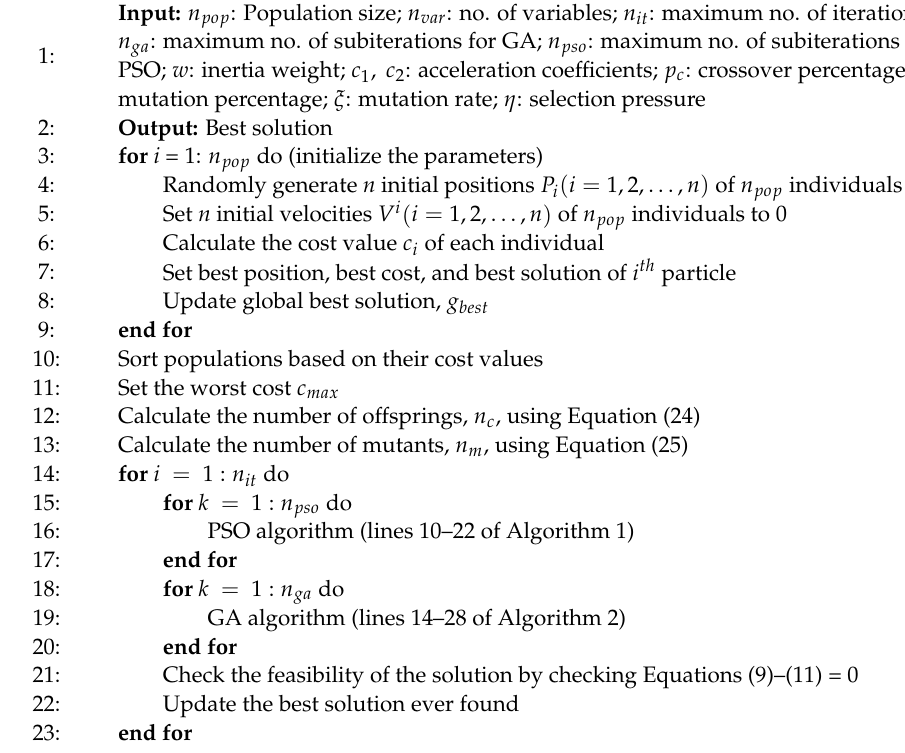
GA algorithm (lines 14–28 of Algorithm